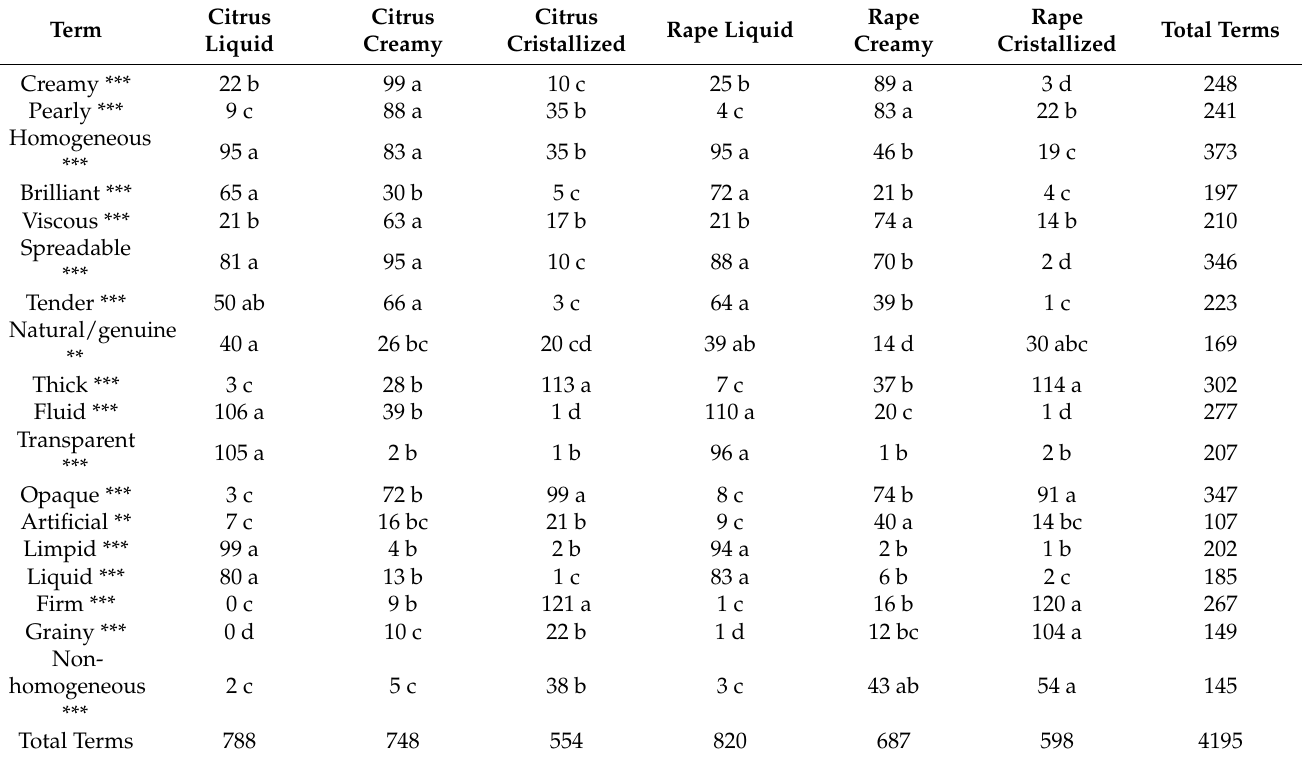
Table 12. Cochran’s Q tests for the citation frequencies of the visual/texture CATA terms.